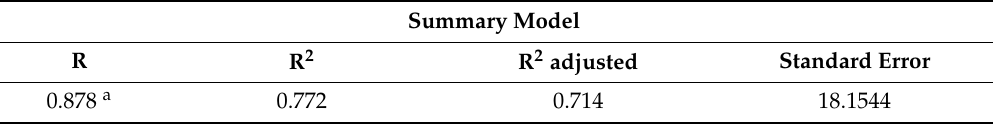
Table 5. Determination coe ffi cients for topographic settlement test and first modulus of PLT ( Φ 600mm) at